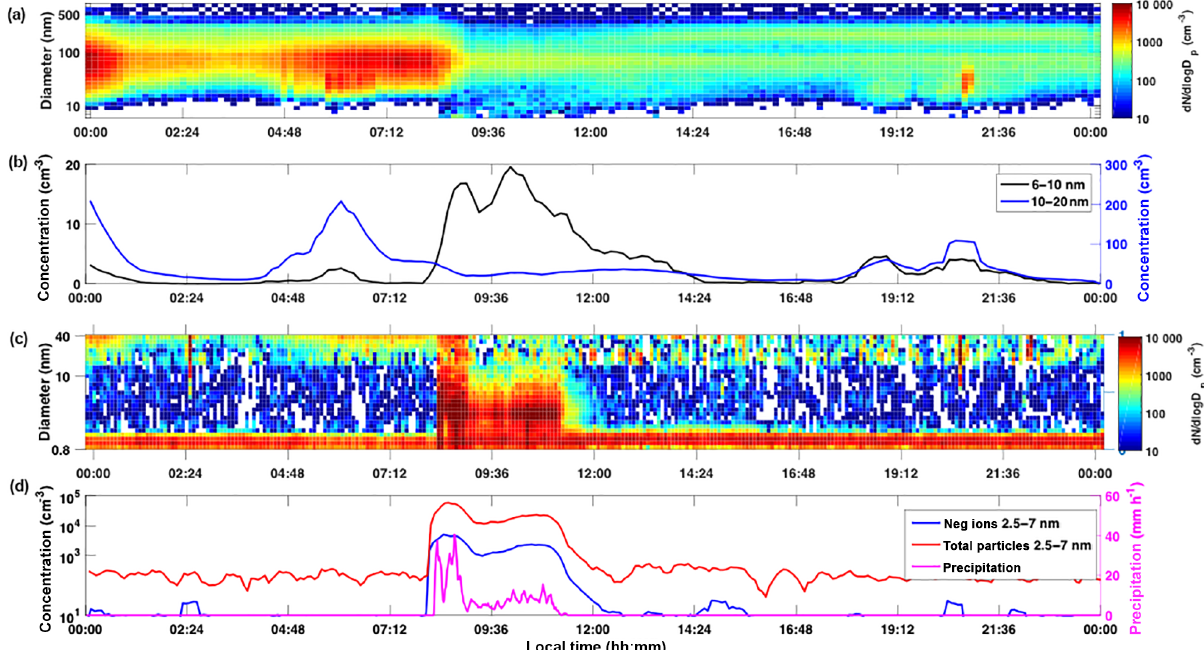
Figure 8. An example for a rain-induced event is shown. Panel (a) shows the surface figure for total particles (DMPS). Panel (b) shows the particle concentrations measured by the DMPS for the size range 6–10nm (black line, left-hand axis) and the size range 10–20nm (blue line, right-hand axis). Panel (c) shows the surface figure for the negative ions measured by the NAIS. Panel (d) shows the negative ion concentrations for 2.5–7nm in blue and the neutral particle concentration in the same size range from the NAIS in red. For the neutral particles, the scale is on the left-hand axis. The pink trace shows the precipitation rate in mmh − 1 on the right-hand